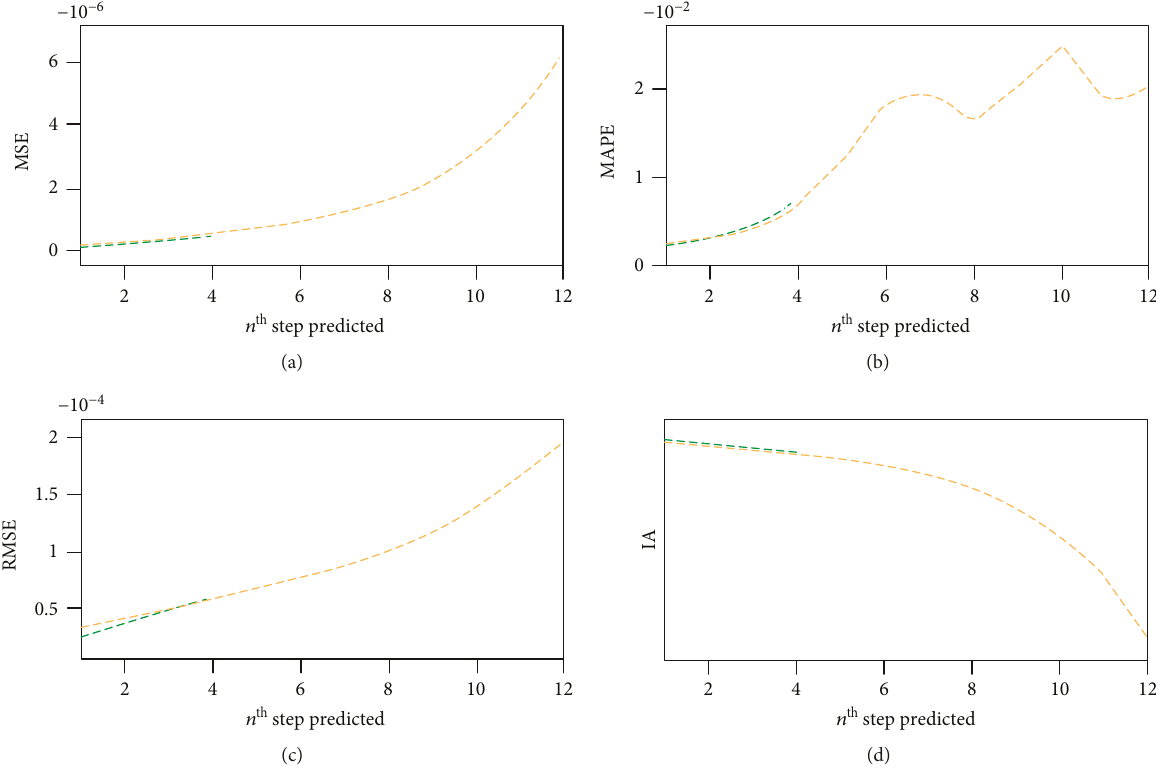
Figure 8: Lorenz system: indicators from LS-SVM — (a) MSE, (b) MAPE, (c) RMSE, and (d)